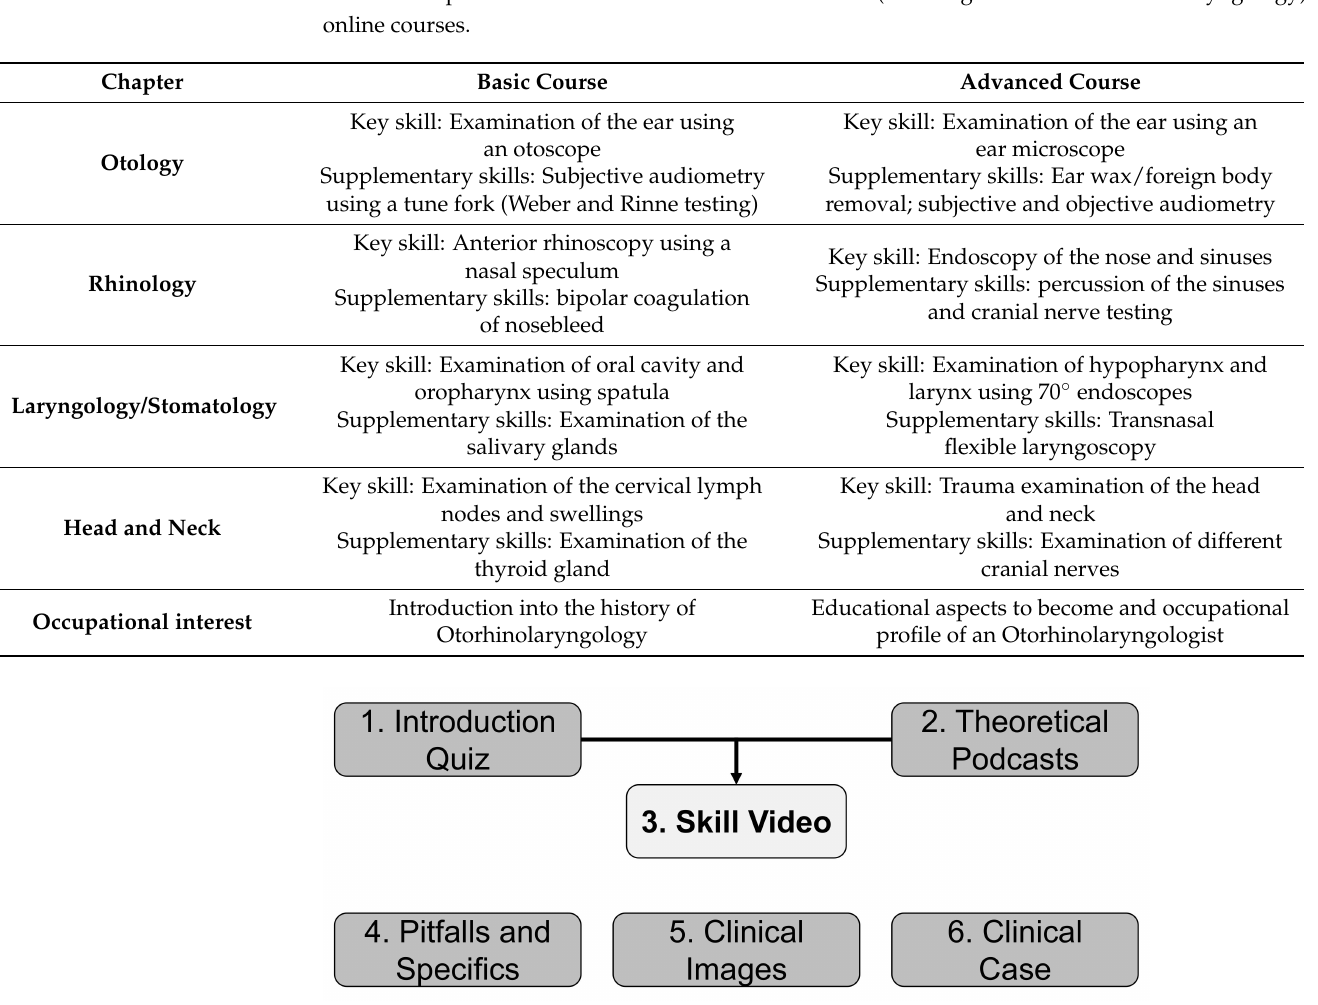
Figure 1. Didactic structure of an organ chapter in the online courses. To teach organ-specific examination techniques, the chapters are composed with similar didactic elements. Initially, an introduction quiz (1) is supposed to activate and self-assess pre-existing knowledge on instruments and anatomy/physiology, afterwards depending on a student‘s demand, theoretical podcasts (2) on anatomy/physiology as well as an instrument gallery are provided and leads to the central video (3) presenting organ-centered examination skills. Thereafter, galleries on pitfalls and specifics of the examination technique (4), a gallery presenting clinical images (5), and a clinical case (6) utilizing the presented examination techniques are supposed to deepen the background and understanding of the organ-specific